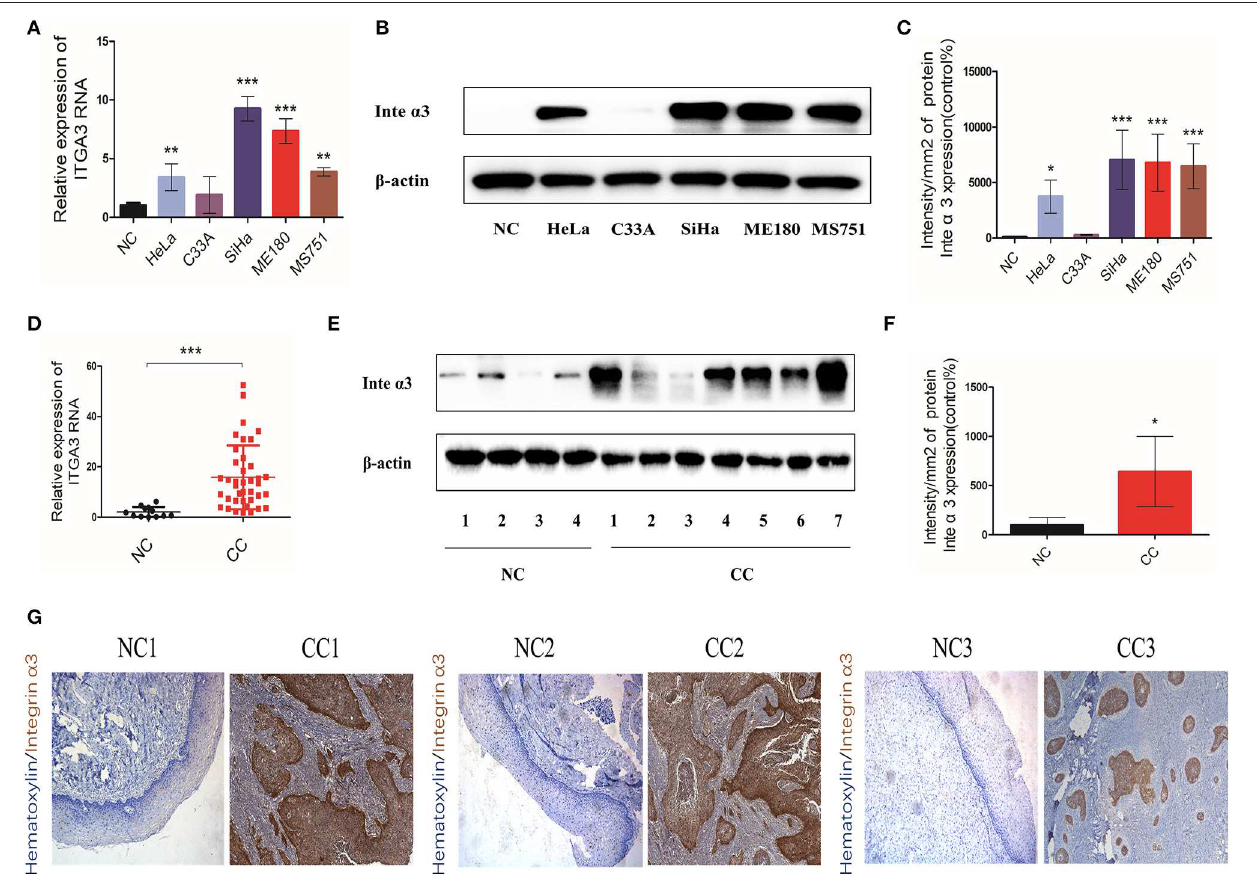
FIGURE 1 | Integrin α 3 is overexpressed in cervical cancer tissue and cell lines. (A) The results of the quantitative real-time (qRT)-PCR analysis showed the mRNA levels of ITGA3 expression in different cervical cancer cell lines. Normal cervix (NC) tissue was used as the normal control. (B) Western blotting was applied to show the protein levels of integrin α 3 in different cervical cancer lines. (C) Quantification results of the protein intensity of (B) . (D) Results of the qRT-PCR analysis of ITGA3 expression in normal cervix tissue ( n = 12) and cervical cancer (CC) tissue ( n = 39). (E) Western blotting was used to analyze the protein expression of integrin α 3 in NC ( n = 4) and CC ( n = 7). (F) Quantification results of the protein intensity of (E) . (G) Immunohistochemistry (IHC) assays were performed to investigate the protein expression of integrin α 3 in three trial pairs of NC and CC. Original magnification: × 100. * P < 0.05 vs. corresponding control; ** P < 0.01; *** P <